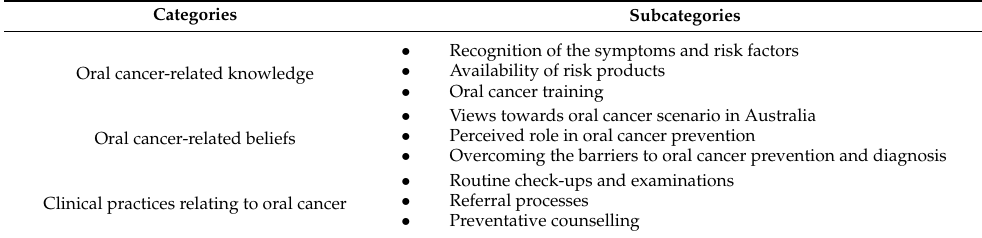
Table 2. Categories and